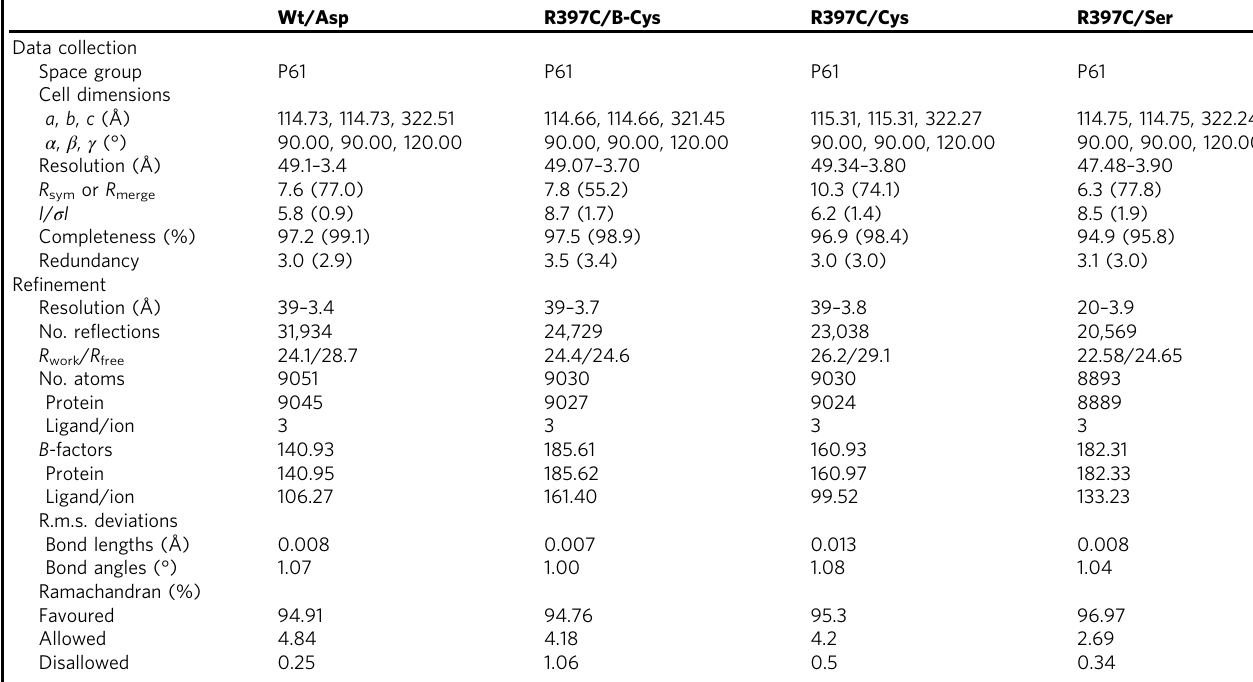
Table 2 Data collection and re fi nement